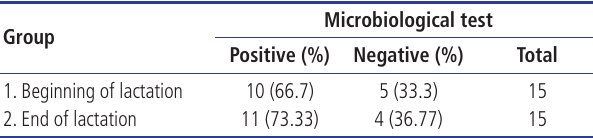
Table 2. Percentages of positive and negative results of microbiological tests from the 30 samples of milk collected in groups with different stages of lactation Group